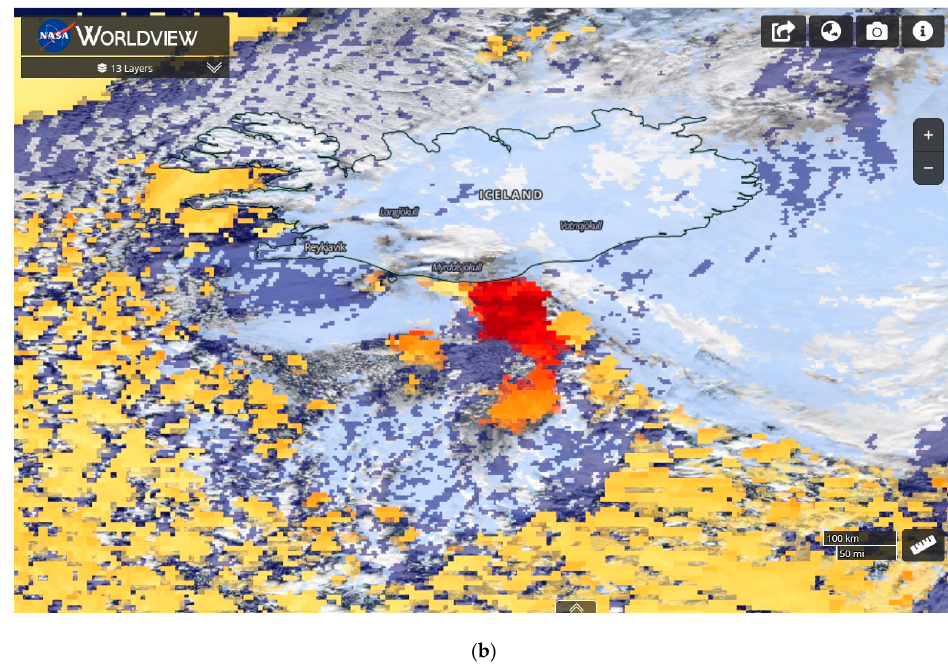
Figure 19. MODIS satellite observed dust plume on 24 October 2019. ( a ) True color; and ( b ) AOD. The model predicted the massive dust storm reaching North Ireland, together with dust driven by a secondary cyclonic circulation orbiting around the Faroe Islands on October 25 (Figure 20a–c). These dust patterns are consistent with the structure captured by NASA MODIS AOD images (Figure 20d–f).